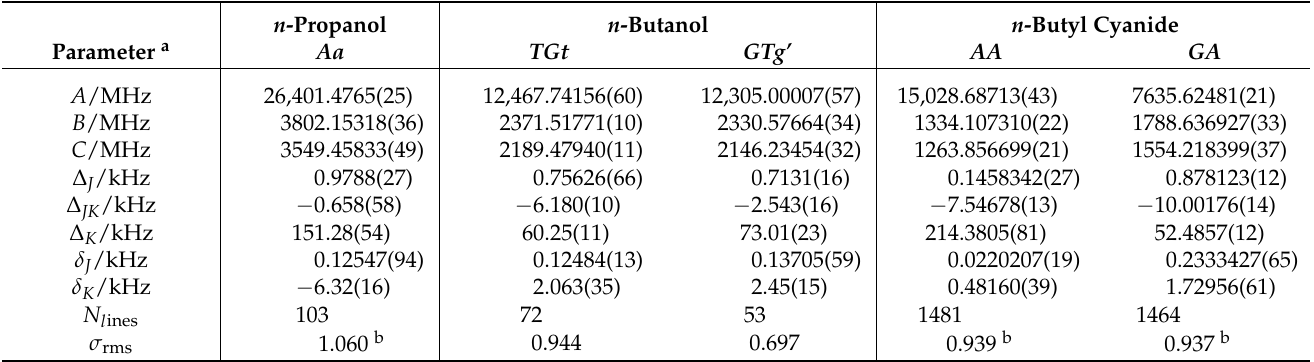
Table 1. Redetermined rotational and centrifugal distortion constants for use as fixed parameters in the evaluation of electric dipole